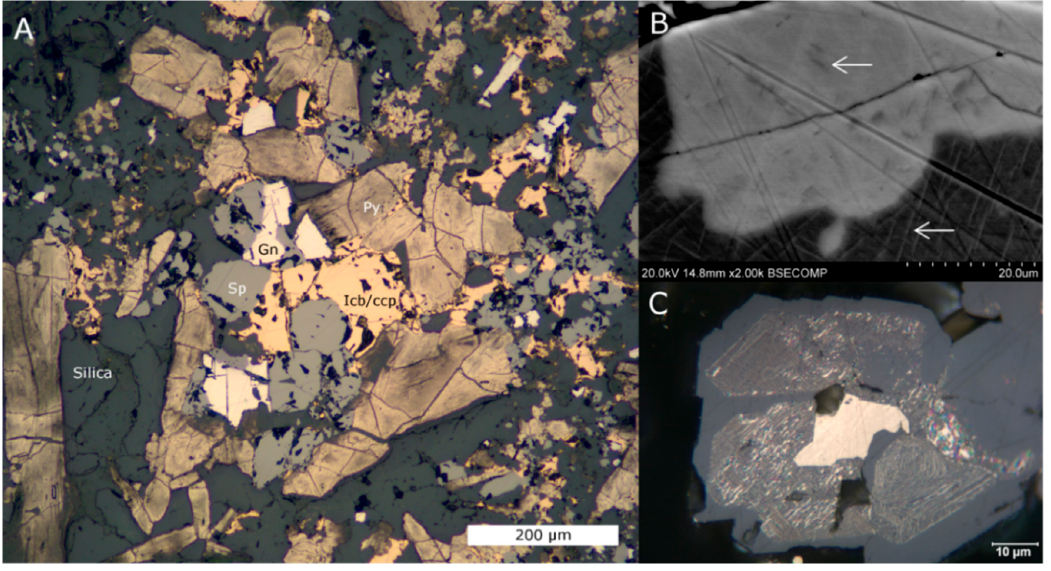
Figure 1. ( A ) Photomicrograph demonstrating sulphide mineralogy and textures: Cu is hosted in isocubanite (Icb) and chalcopyrite (ccp) intergrowths; Zn in sphalerite (Sp); Pb in galena (Gn) and pyrite (Py), highly altered in this sample. ( B ) Gradual decrease in chalcopyrite inclusions (upper arrow) in sphalerite (light grey), with the distance from the Cu-phase. Isocubanite (dark grey) host lamellae of chalcopyrite (lower arrow). ( C ) Various modes of sphalerite and chalcopyrite-iscocubanite textures. The centre yellow grain is an intergrowth of isocubanite and chalcopyrite. Several initial grains of sphalerite, with strong chalcopyrite disease, are rimmed by zones of homogenous sphalerite.